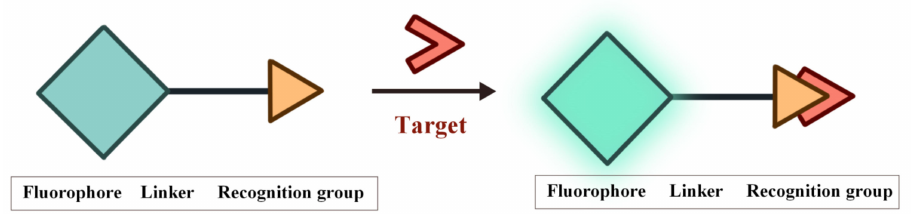
Figure 1. The structure of FOSMPs and its recognition of the